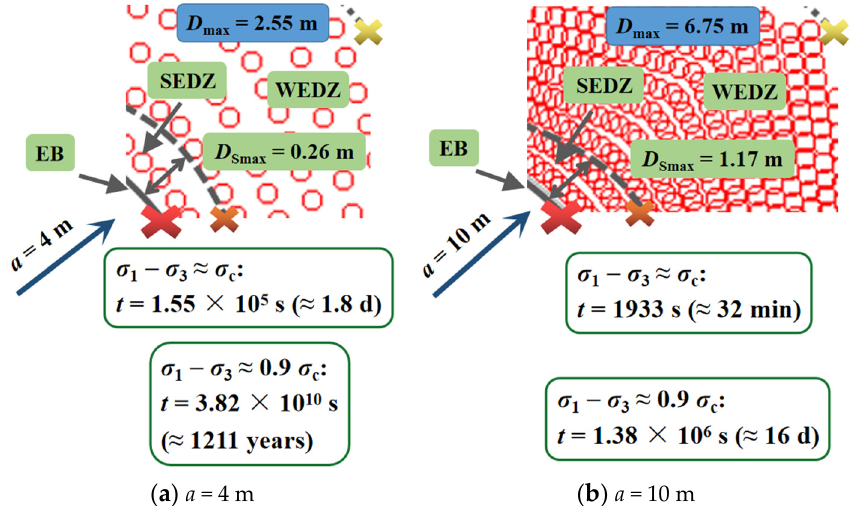
Figure 11. Time-delayed failure laws in the EDZ for the round tunnel cross section at the depth of 1900 m ( a = 4 m ( a ) and 10 m ( b )).